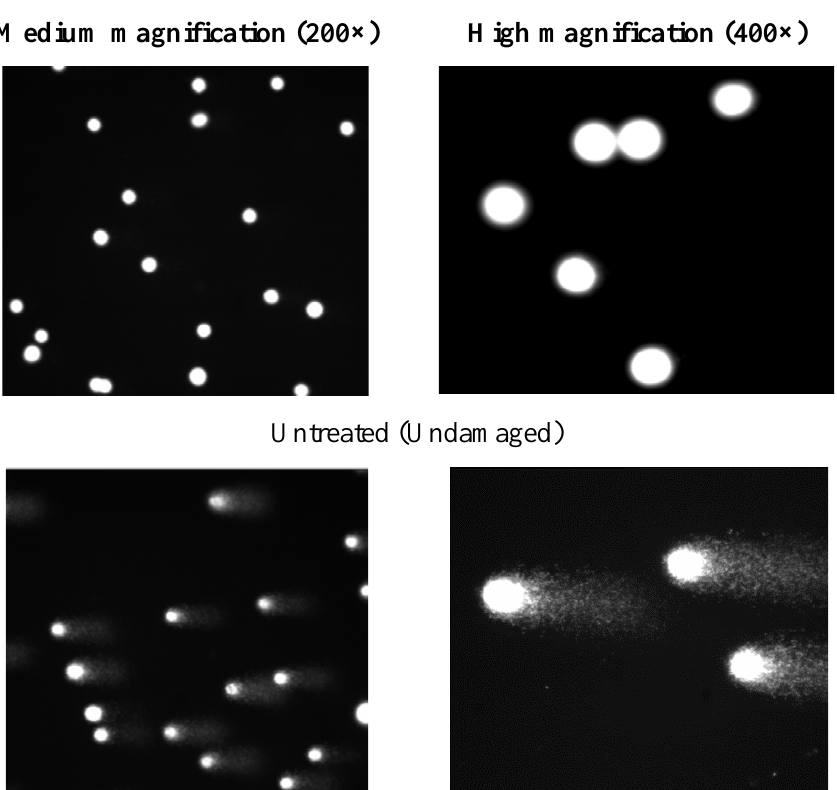
Figure 5. Cont Figure 5. Cont.